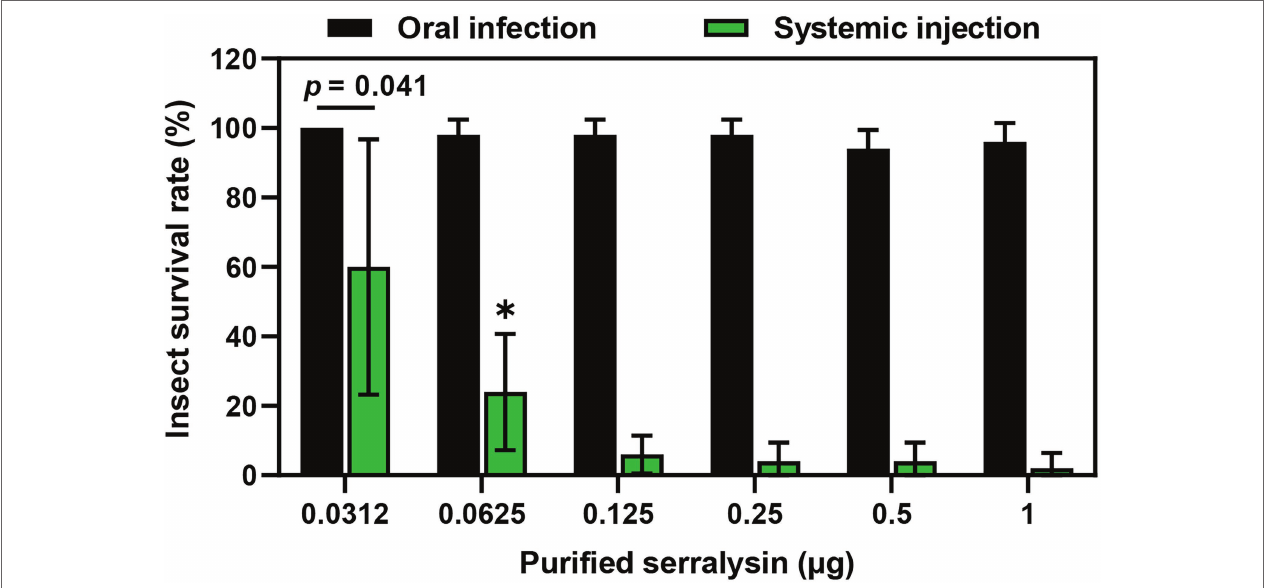
FIGURE 3 | Insecticidal activity of serralysin. Purified serralysin was orally administered and systemically injected into the joint of the hind leg, which connects to the thorax of the insect. Survival was monitored 1 day after systemic injection. Data are expressed as the mean ± SD ( n = 10) and are representative of five independent experiments. Asterisks indicate the significant differences between groups (* p < 0.01; unpaired t -test).